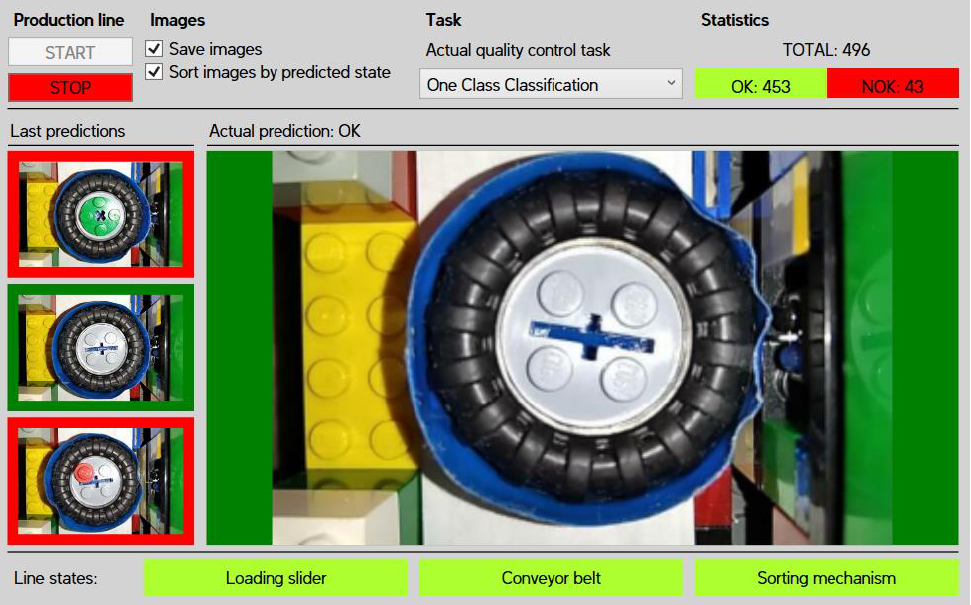
Figure 15. GUI window design in WPF environment.